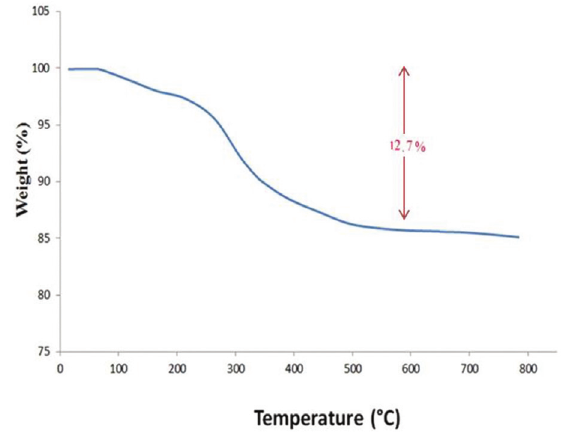
O @SiO -L-proline nanoparticles. 3 4 2